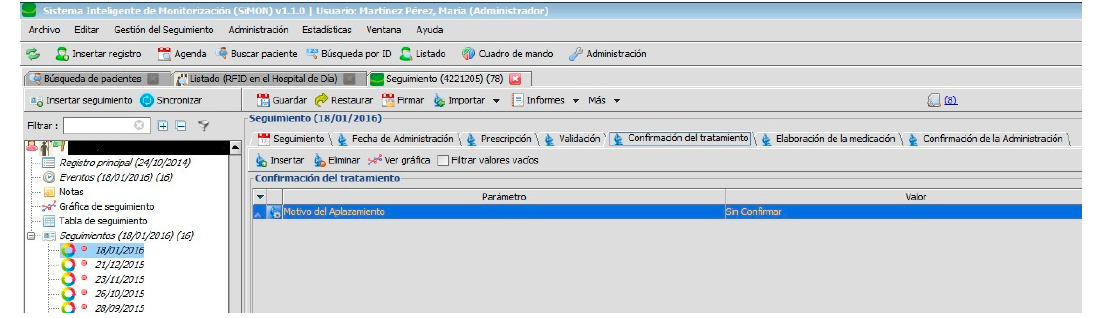
Figure 7. Registry of reasons for patient not receiving medication.